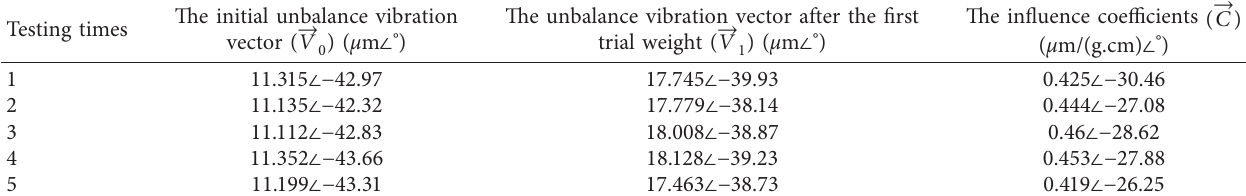
Table 1: The experiment data before and after trial